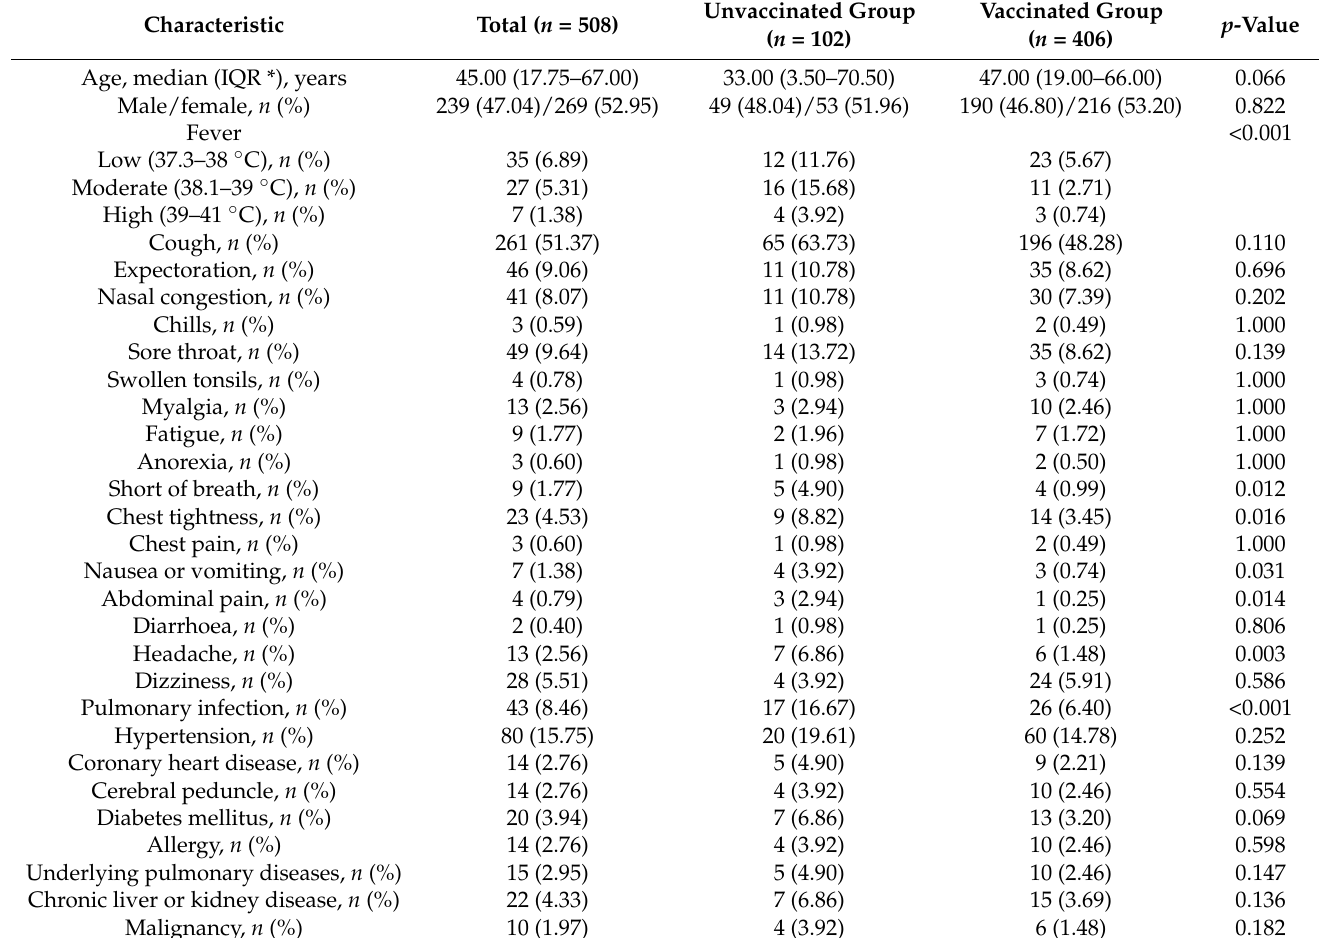
Table 1. Comparison of the clinical characteristics between the unvaccinated and vaccinated